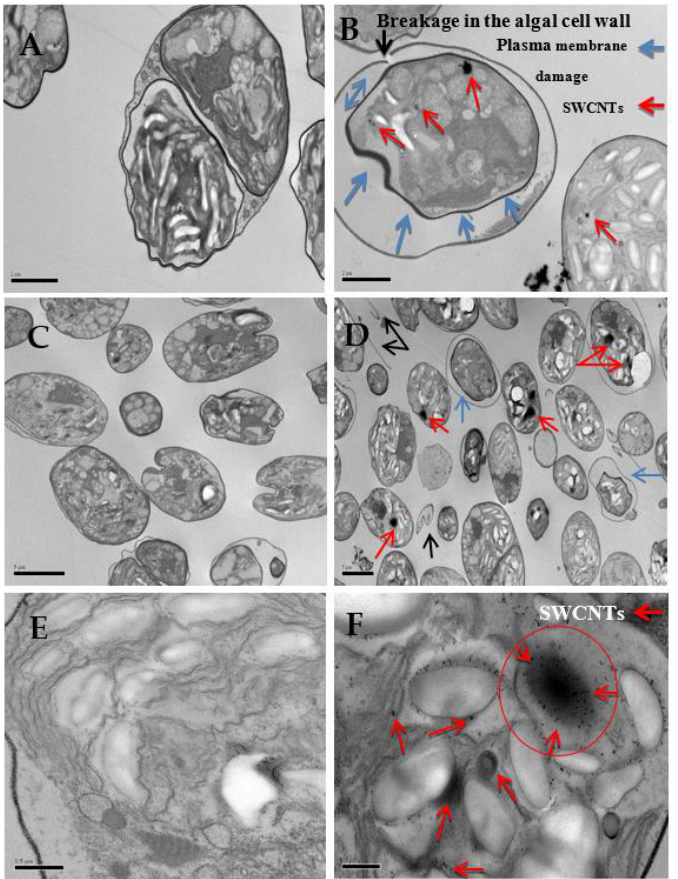
Figure 8. TEM images of control cells with intact algal cell wall and plasma membrane ( A , C , E ) and from culture medium containing final 500 µg L − 1 SWCNTs ( B , D , F ); cell wall breakage (black arrows); plasmolysis (blue arrows) and internalization of the SWCNTs (red arrows). Scale bars 2 μm ( A , B ); 5 μm ( C , D ); 0.5 μm ( E , F ).